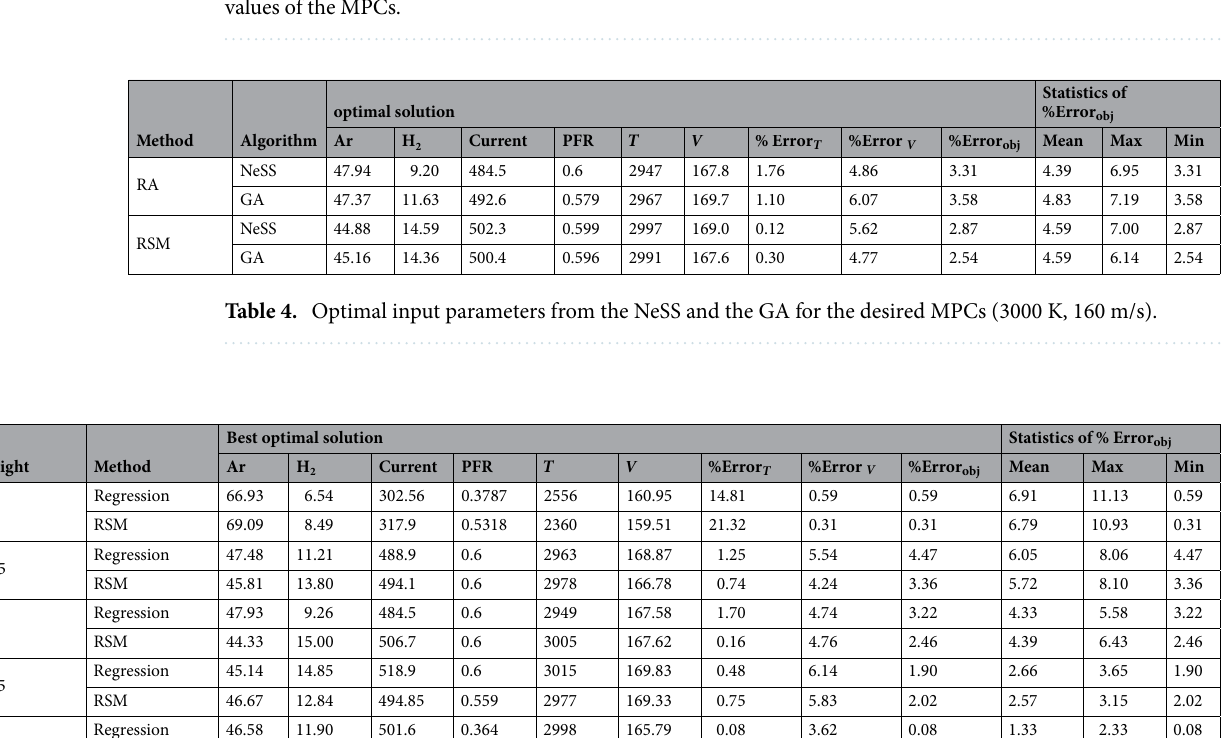
Figure 5. Plot of particles’ mean ( a ) temperature and ( b ) velocity versus the Ar and the H 2 flow rates. The orange [blue] surface represents results from the RA [RSM]. The two surfaces are close to each other. For the Ar and the H 2 flow rates lying on the curve of intersection of the two surfaces, the RA and the RSM give identical values of the MPCs.